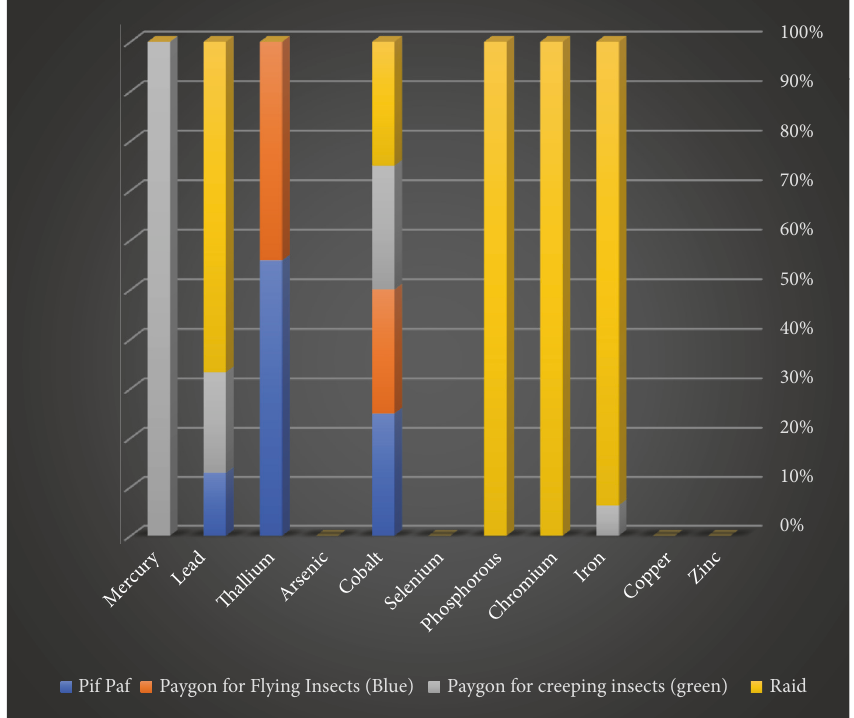
Figure 3: Proportions of the studied elements in the gaseous insecticides